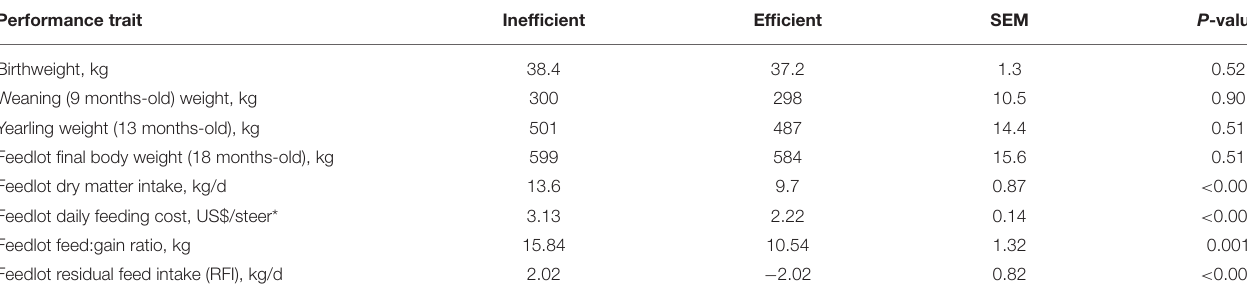
TABLE 1 | Performance of the efficient and inefficient steers ( n = 7 efficient and n = 8 inefficient) at different points in the beef production continuum. Performance trait Inefficient Efficient SEM P